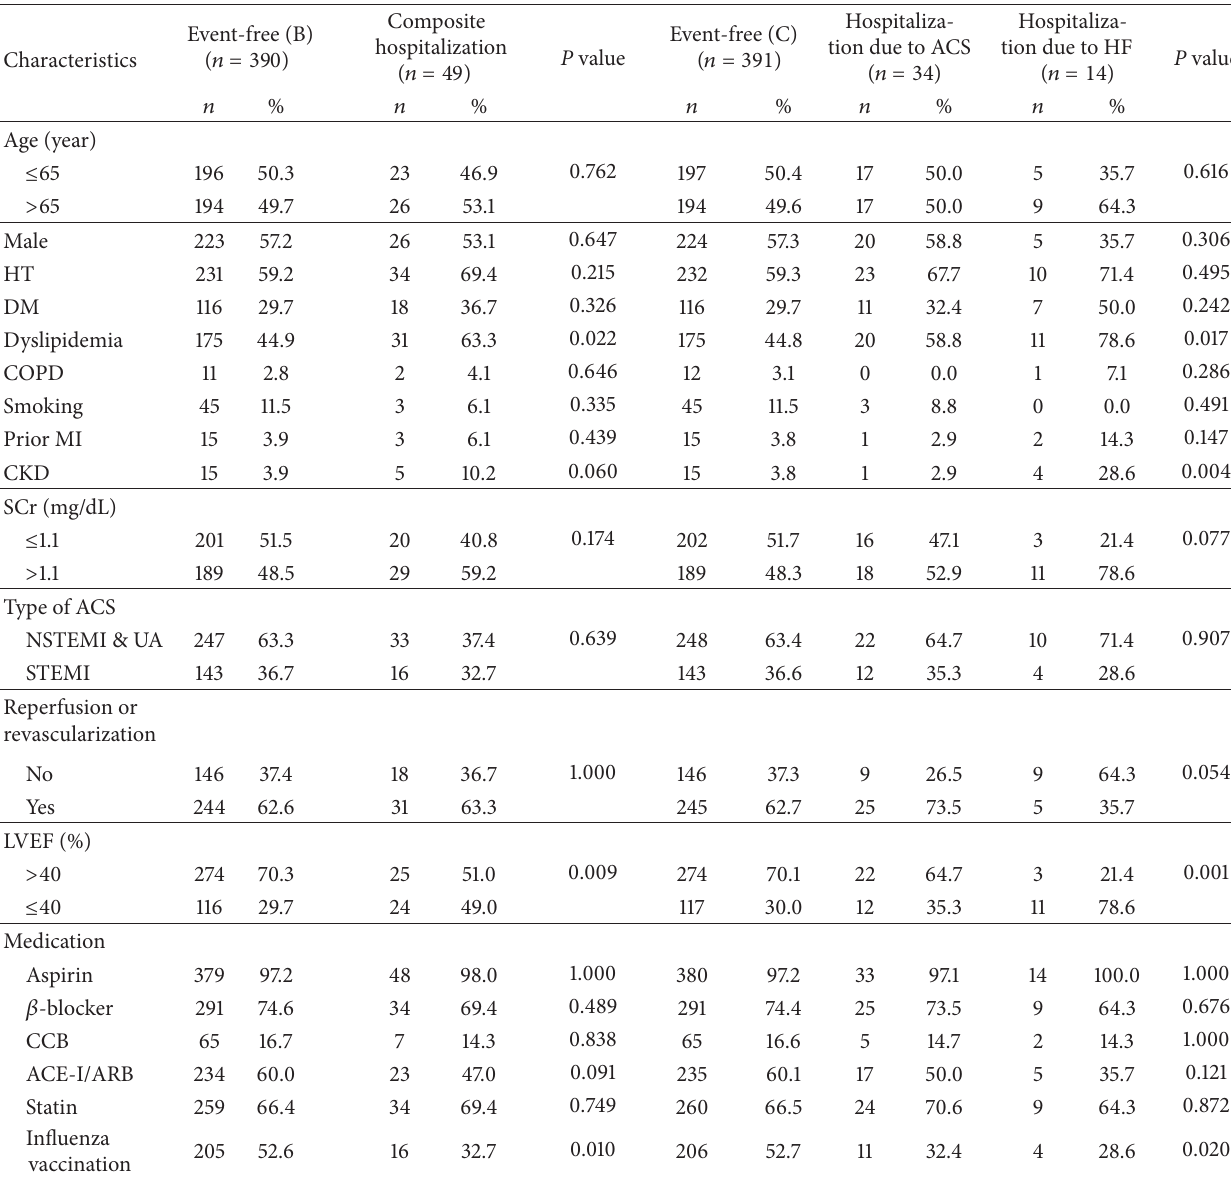
Table 2: Patients’ characteristics of composite outcomes of hospitalization (ACS, HF, or stroke), hospitalization due to ACS, and hospitalization due to